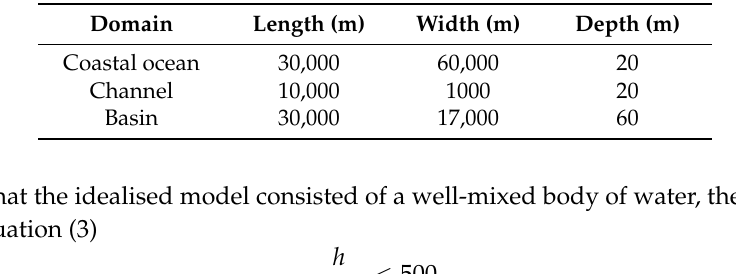
Table 1. Dimensions of the model